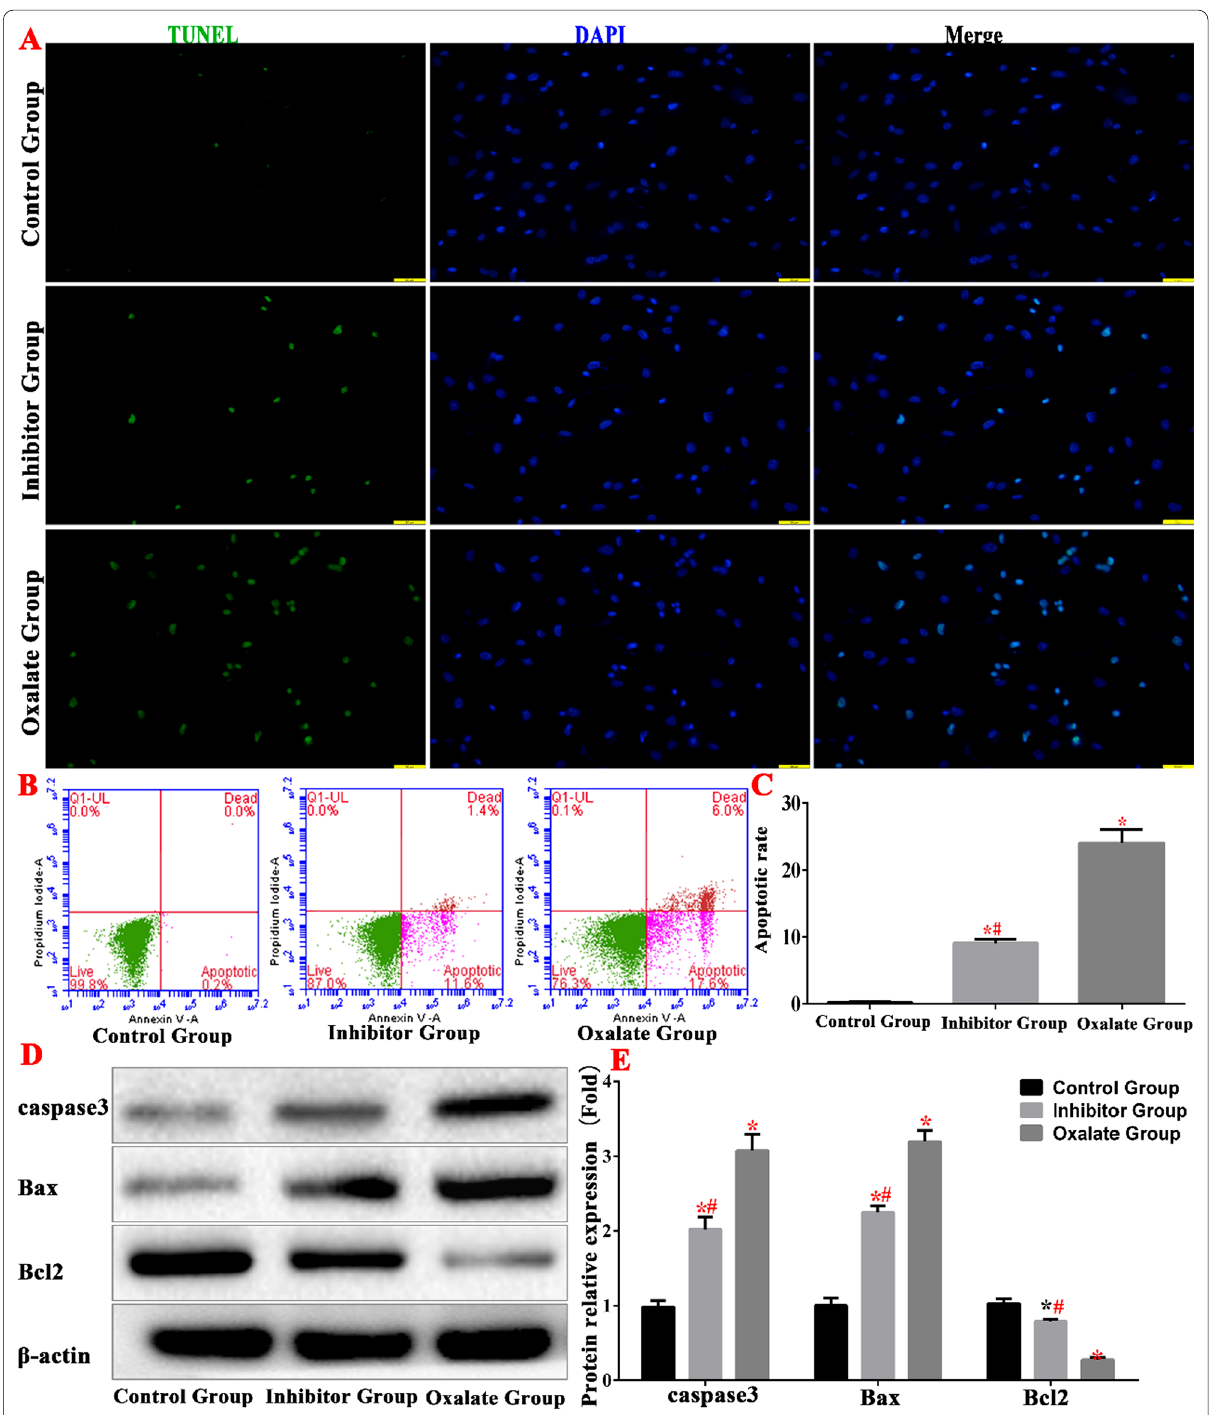
Fig. 6 Oxalate-induced apoptosis of HK-2 cells. A detection of apoptosis in each groups. B , C Comparison of apoptosis detection in each group by flow cytometry. D , E Western blot was used to detect the expression of apoptosis-related proteins in each group. (*compared with normal control group, P < 0.05.* (Red) Compared with control group, P < 0.01. #(Red) Compared with oxalate group, P <